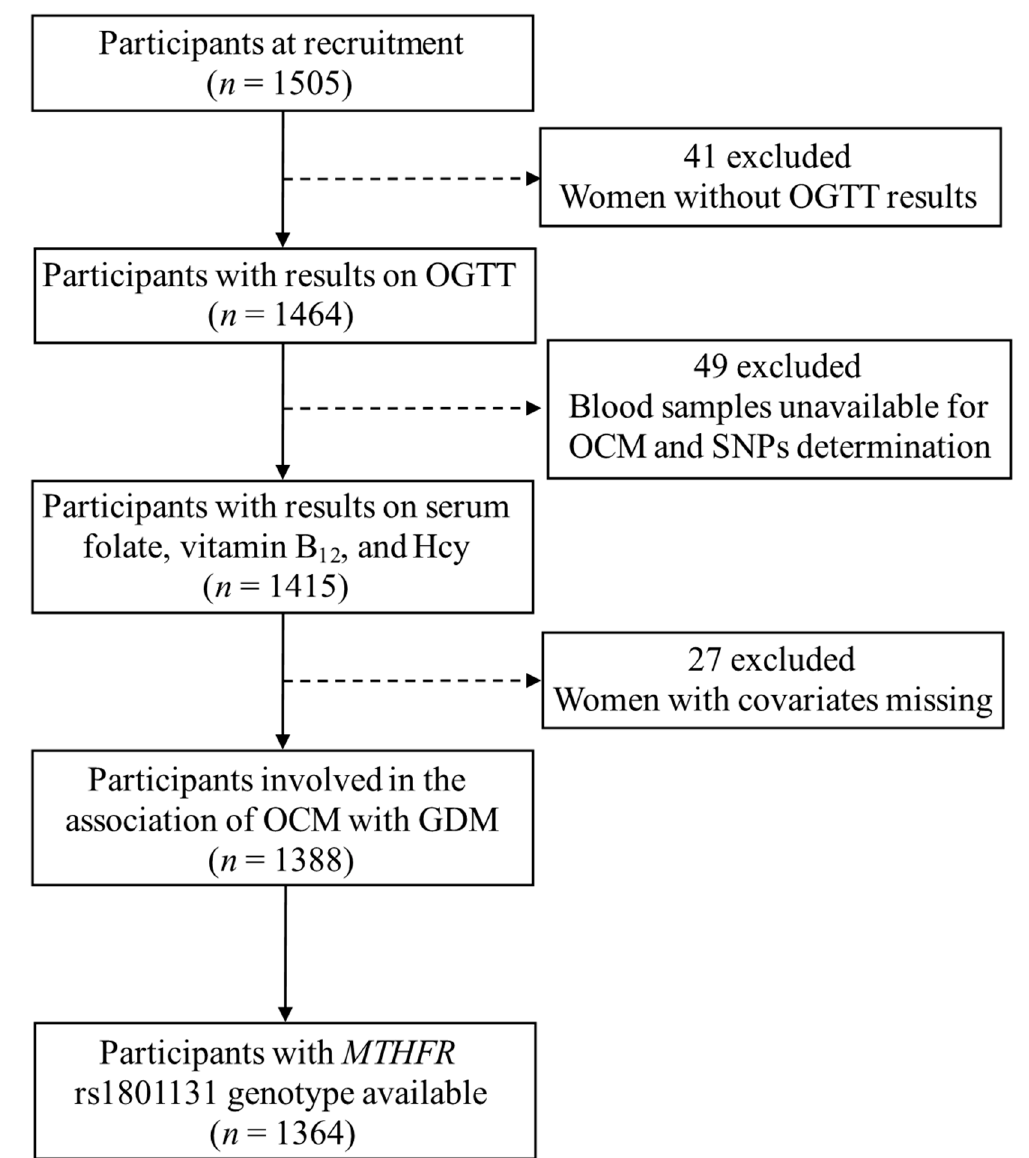
Figure 1. Study flowchart. GDM, gestational diabetes mellitus; Hcy, homocysteine; MTHFR , methylenetetrahydrofolate reductase; OGTT, oral glucose tolerance test; OCM, one-carbon metabolism; SNPs, single nucleotide polymorphisms.